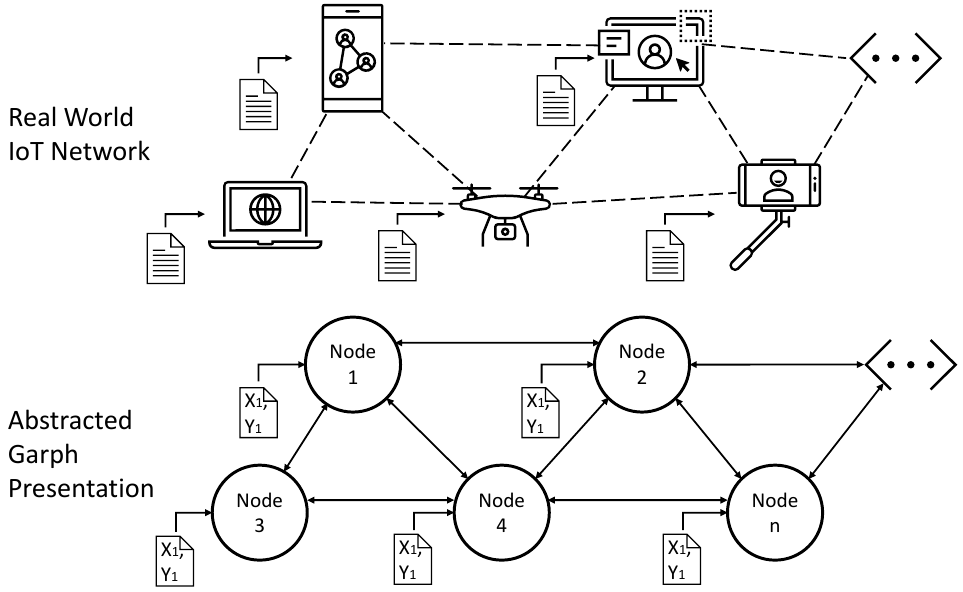
Figure 1. The real-world network scenario with its corresponding abstract graph